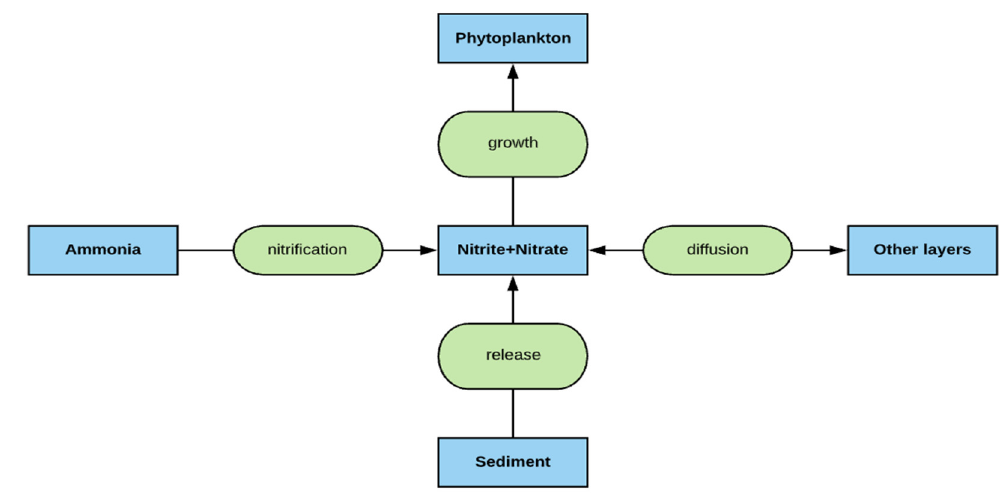
Figure 5. Schematic diagram of nitrate-nitrite cycle modeled by MINLAKE2020.